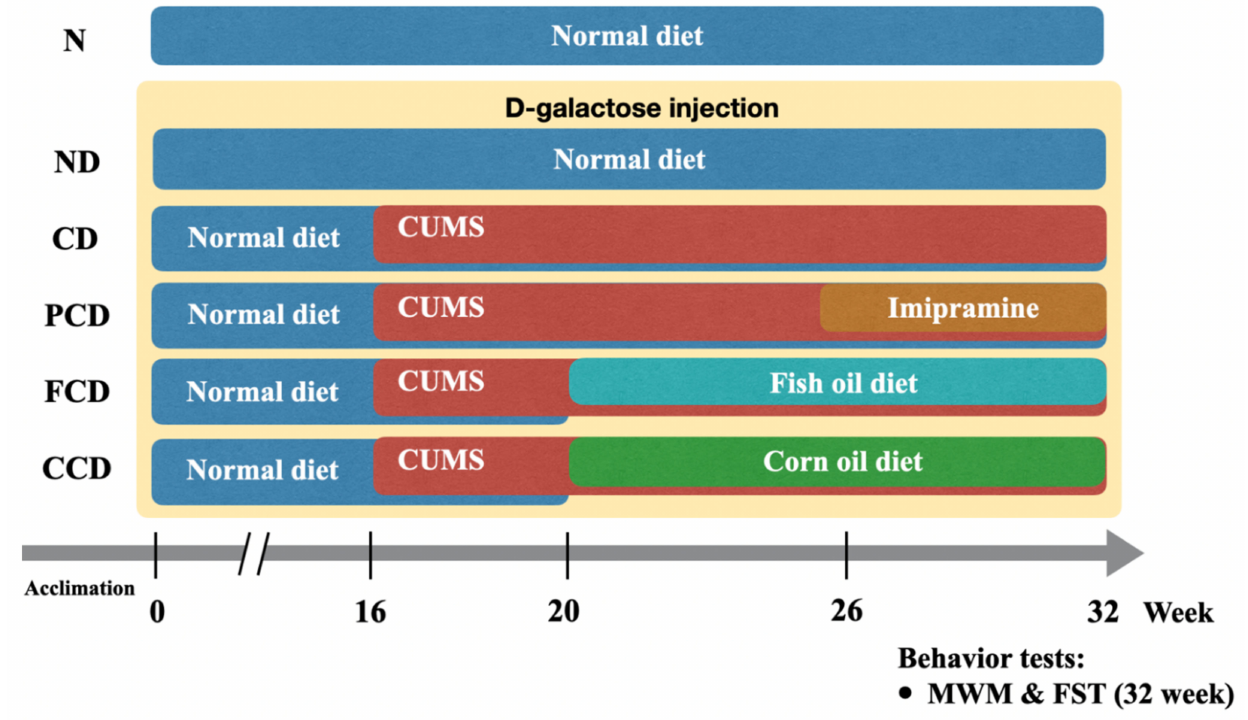
Figure 1. Flow chart of the experiment protocol. Rats were divided into six groups ( n = 6). CUMS: chronic unpredictable mild stress; SPT: sucrose preference test; MWM: Morris water maze; FST: forced swimming